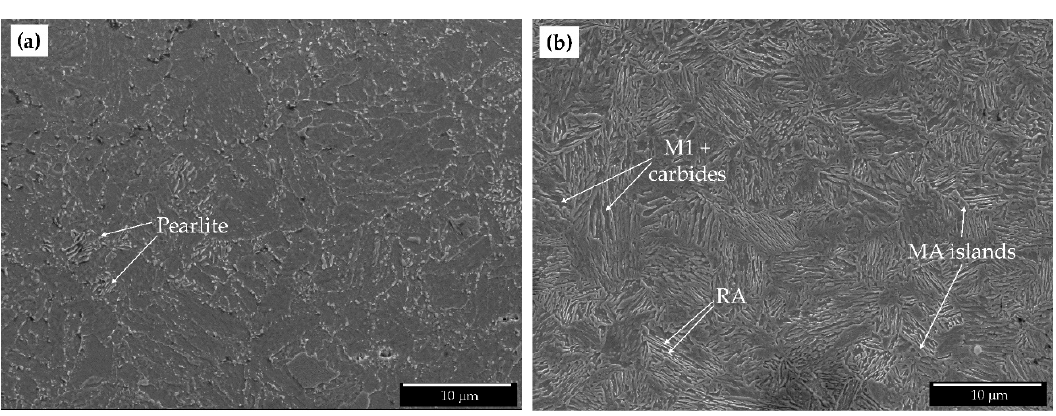
Figure 4. Field emission gun scanning electron microscopy (FEGSEM) micrograph of the Q&P processed alloys partition-treated at 650 °C for 500 s in alloys: ( a ) 2Mn and ( b ) 6Mn2Ni.